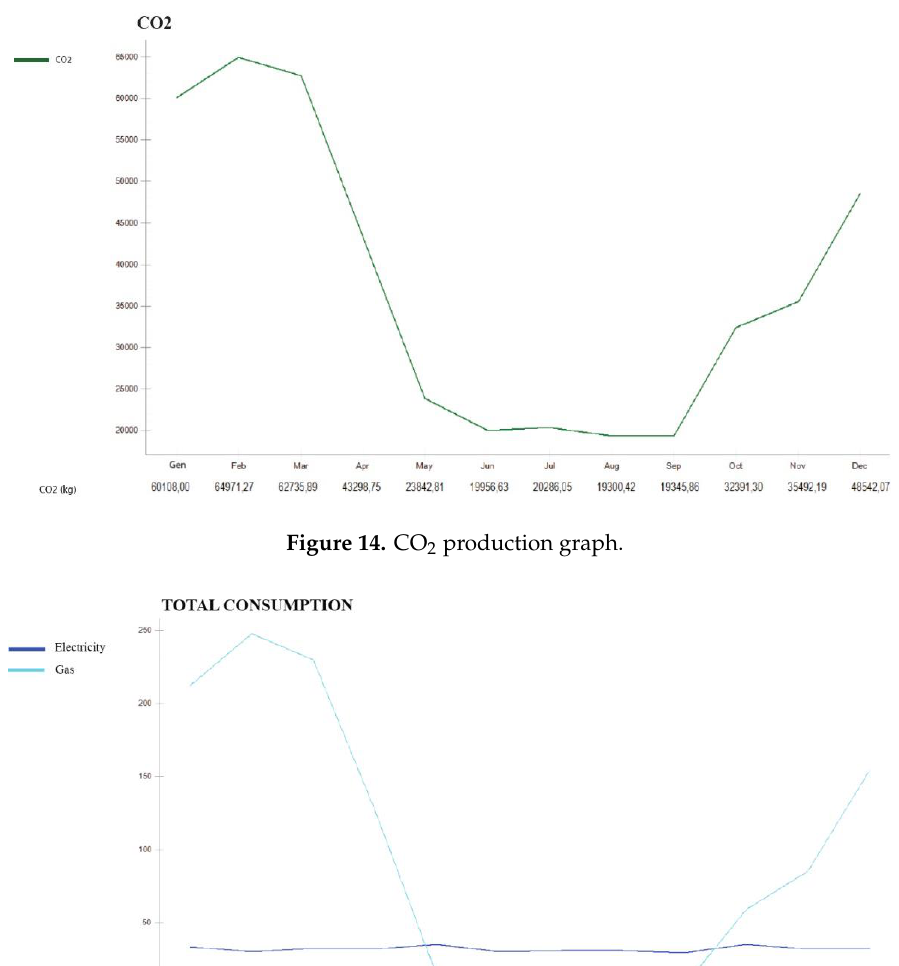
Figure 13. Envelope and ventilation graph.